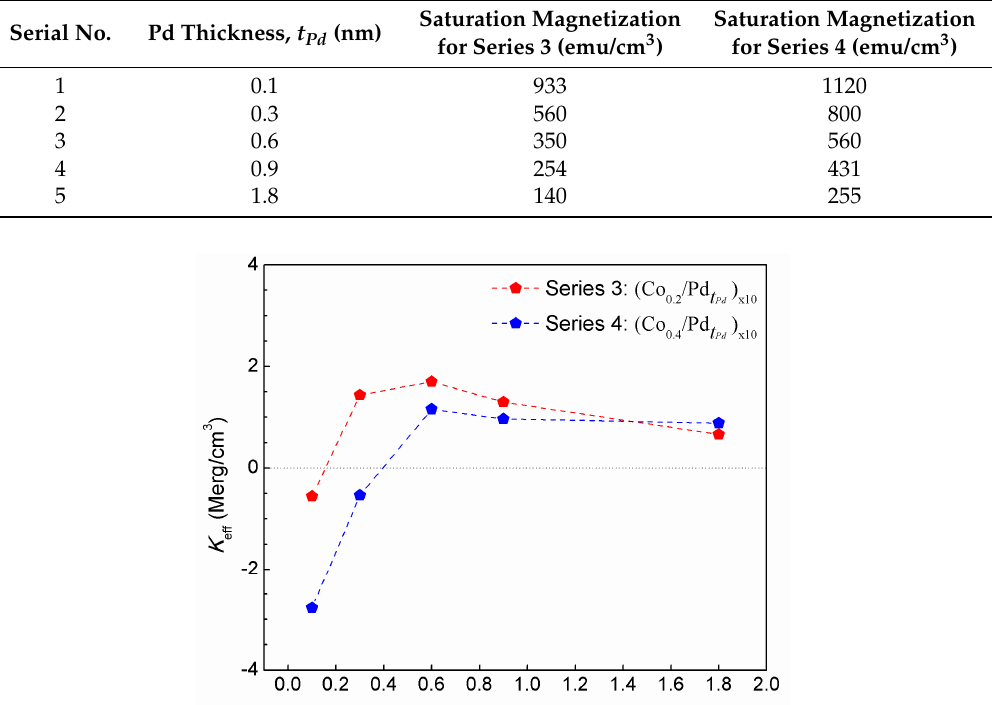
Pd) × 10 . Pd ) × 10 ] and series 4 [(Co 0.4 /Pd t ) × 10 ] samples Pd Pd